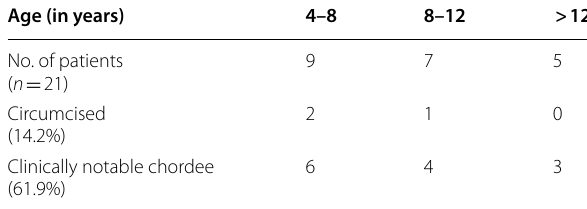
Table 1 Patient demographics and characteristics